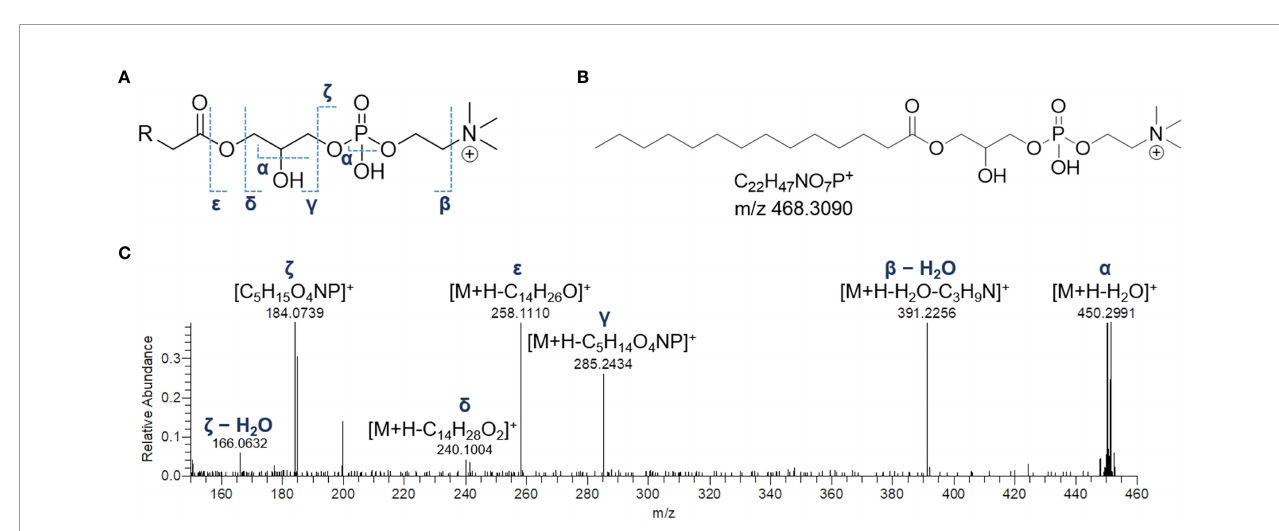
FIGURE 4 | The fragmentation patterns of lyso-glycerophosphocholines (A) . Chemical structure of a representative lyso-glycerophosphocholine from Botrylloides niger , namely 1-myristoyl- sn -glycero-3-phosphatidylcholine (LPC 14:0) (B) and HR ESI-MS 2 spectrum of the relevant [M+H] + adduct (C)